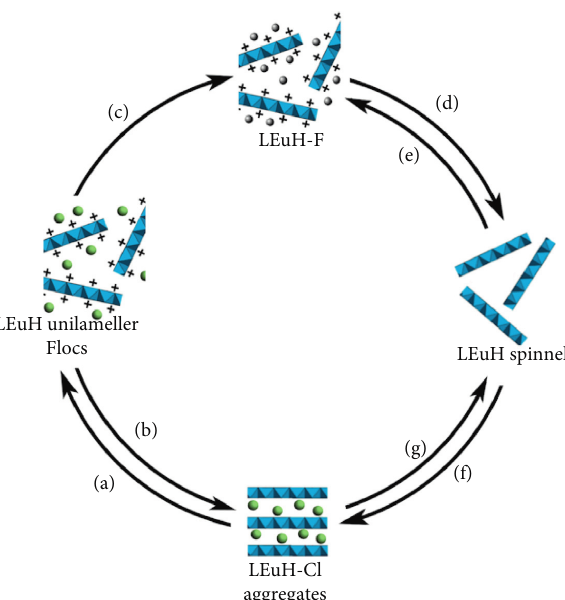
Figure 9: Schematic diagram representing the fluoride sorption process using layered rare-Earth hydroxides unilameller flocs as sorbents: (a) flocculation, (b) self-assembly, (c) fluoride adsorption, (d) calcination, (e) fluoride adsorption, (f) chloride adsorption, and (g) calcination.